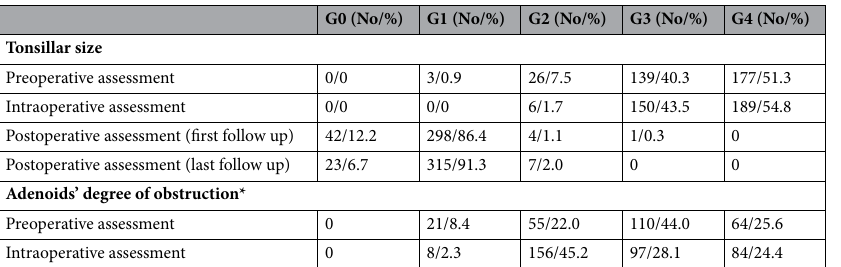
Table 1. Preoperative, intraoperative, and postoperative assessment of the tonsils; and preoperative and intraoperative assessment of the adenoids. 95 patients (27.5%) did not have an X-ray done. G grade, No number of patients. *Postoperative adenoids assessment was not done as routine as it required an X-ray or endoscopy, which were not indicated unless revision surgery was